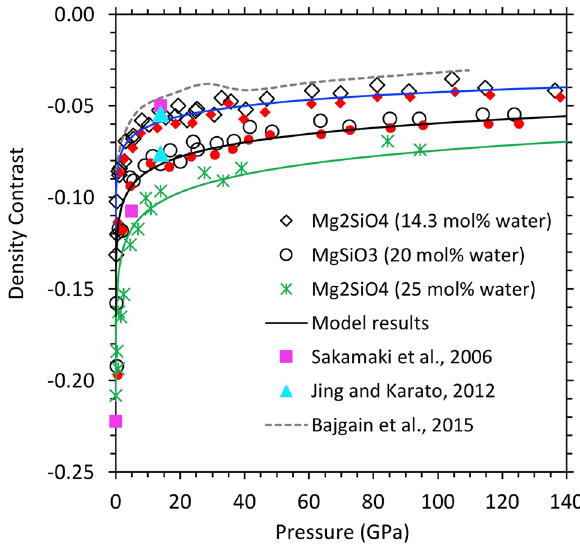
Figure 7. Density contrast between dry and hydrous melts for iron-free (open symbols and asterisks) and iron- bearing (filled small symbols) compositions as a function of pressure. The model results using Eq. 4 are shown by solid curves for the corresponding melt compositions. The previous results are shown for peridotite melt 12 containing ~ 20 mol% water at 0, 5, and 14 GPa at 1873 K (magenta squares), hydrous ultramafic melt 31 with 20 and 25 mol% water at 14 GPa and 2173 K (cyan triangles), and hydrous model basalt 6 with 13 mol% water along the 3000 K isotherm (dashed